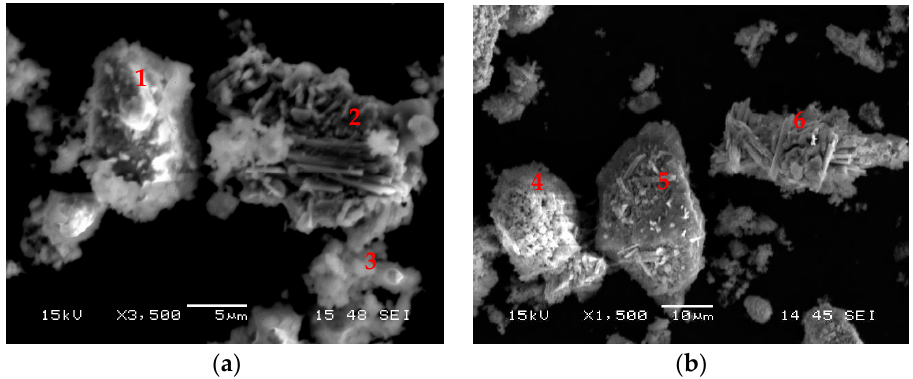
Figure 14. SEM (scanning electron microscope) mineral identifications in CaO, Na 2 CO 3 and bauxite residue ( a ) Sinter product; (1) Sodium aluminate, (2) Calcium ferrite, Calcium titanate, (3) Calcium silicate, sodium calcium silicate; and ( b ) Leached residue; (4) Calcium ferrite, calcium silicate, (5) Calcium ferrite, grossular product, (6) Calcium ferrite (more details in supplementary materials).